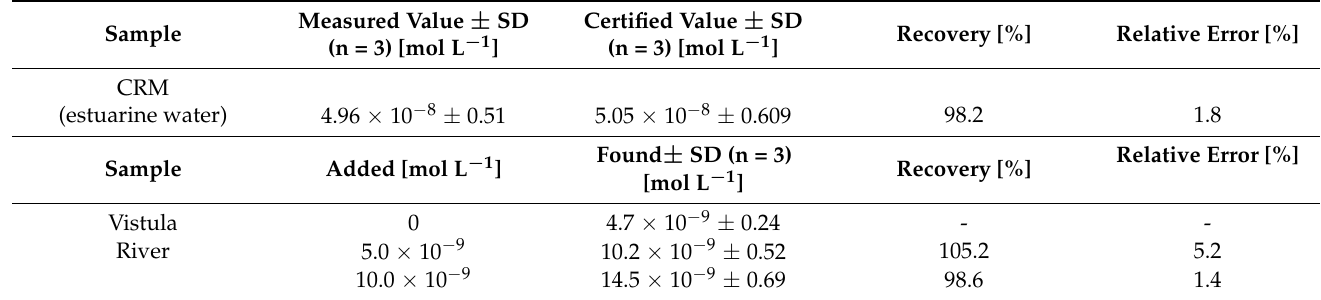
Table 3. Results of V(V) determination in environmental water